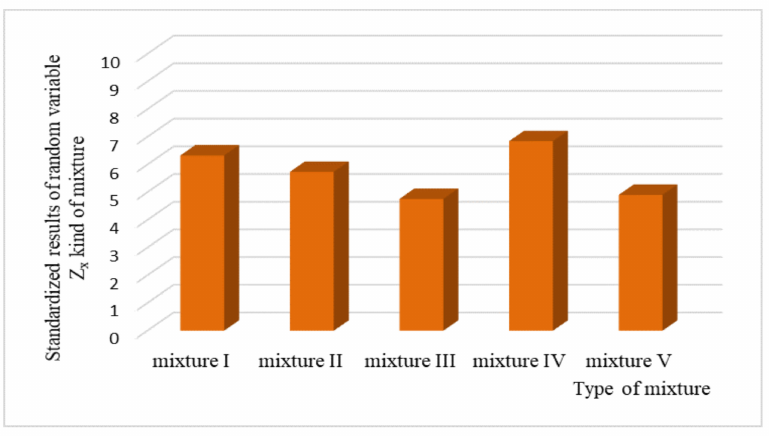
Figure 5. Graphic interpretation of the value of random variable Z